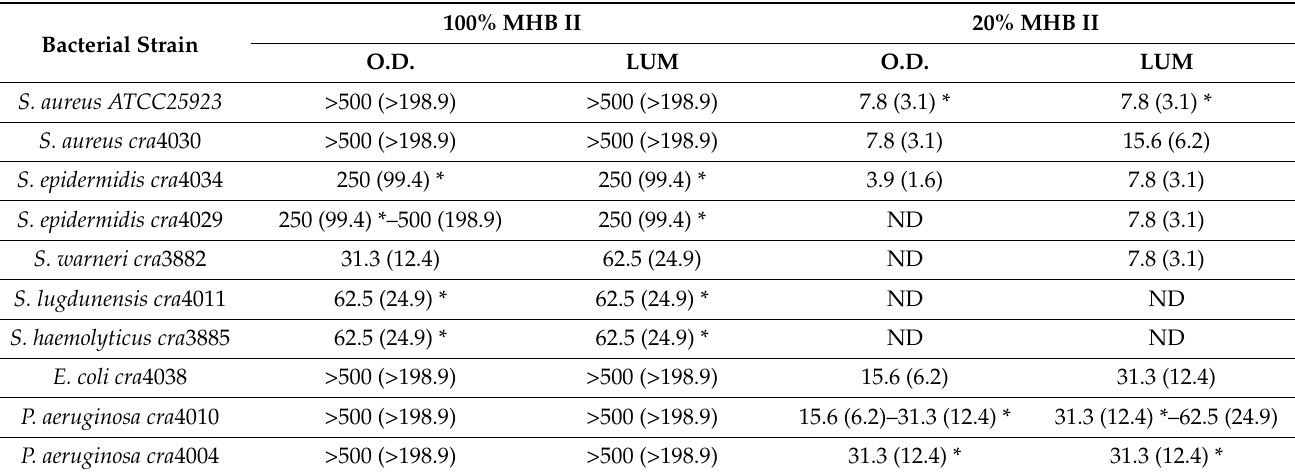
Table 1. MIC values obtained in undiluted and diluted MHB